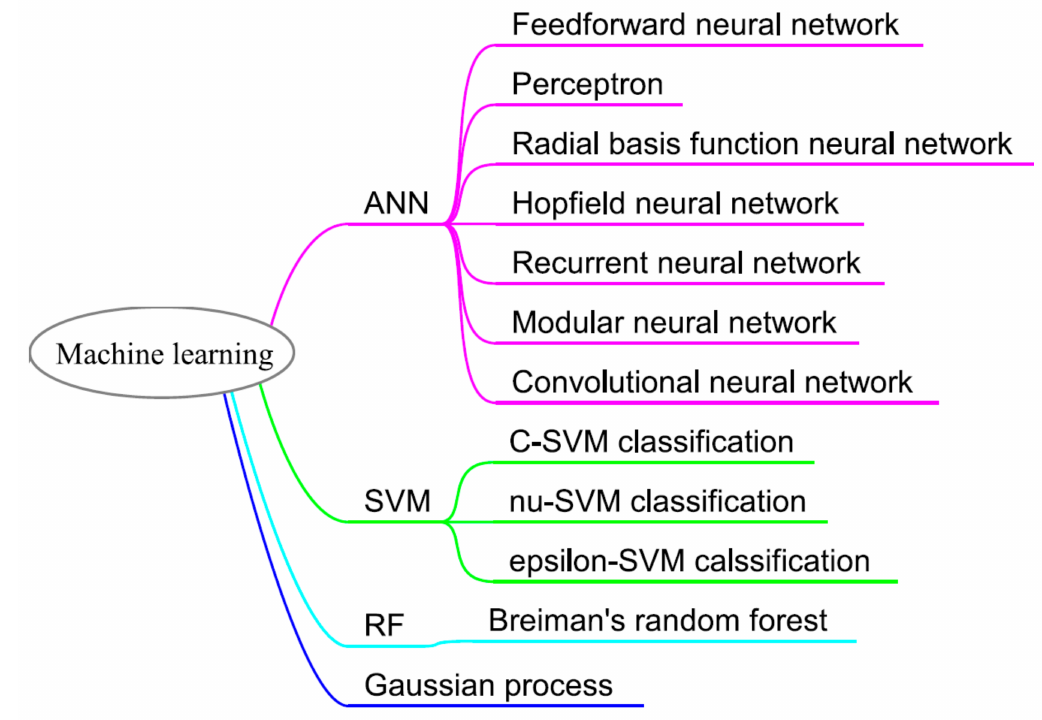
Figure 8. Machine learning techniques and their corresponding